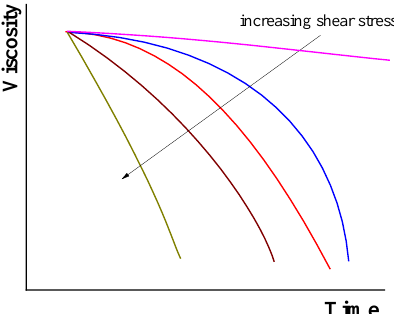
Figure 7. Thixotropic behavior demonstrated by the viscosity evolution at different shear stresses. Shear-induced thixotropic transitions between different structural states are nicely illustrated by the bifurcation of the viscosity when self-oscillations occur in a certain range of given shear rates (Figure 8 [31]). Self-oscillations in shearing can be a consequence of different reasons, including the viscoelasticity of a substance, but in some cases, this effect is undoubtedly due to the rupture and coalescence of clusters in a liquid matrix, which was directly observed in experiments [32]. The formation of a cluster was even considered as a kind of phase transition [33].